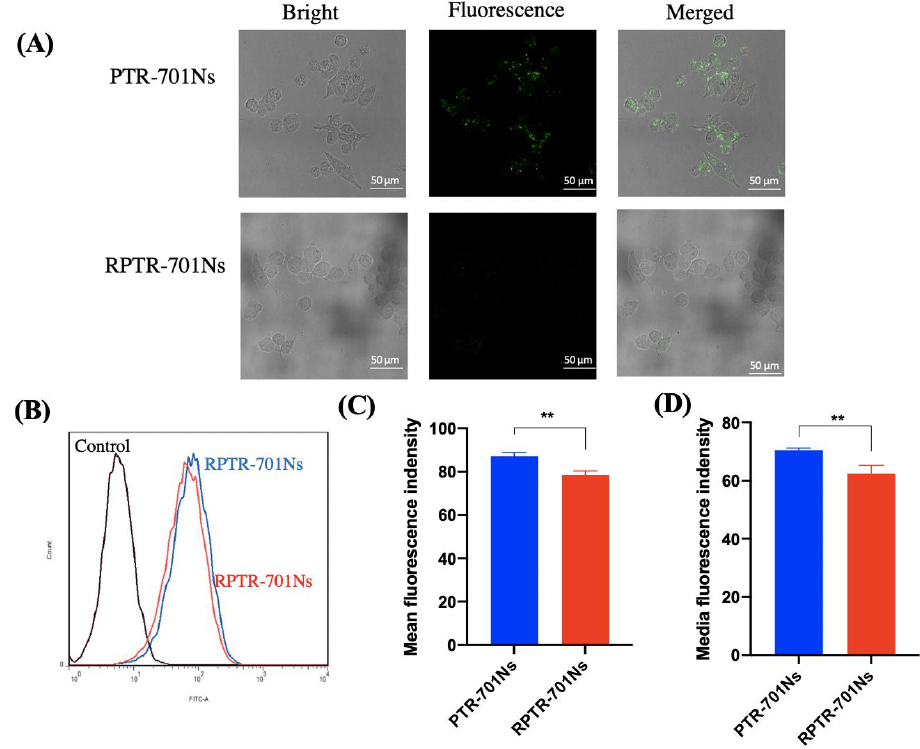
Figure 7. Immune-escaping capability of RPTR-701Ns. ( A ) LSCM images of uptake of PTR-701Ns and RPTR-701Ns by RAW264.7 cells. PLGA was labelled with DiO (green). ( B ) Fluorescence intensity was examined by a flow cytometer. ( C ) Quantitative analysis of the mean and ( D ) Media fluorescence intensity. Data were presented as mean ± SD ( n = 3), ** p < 0.01.